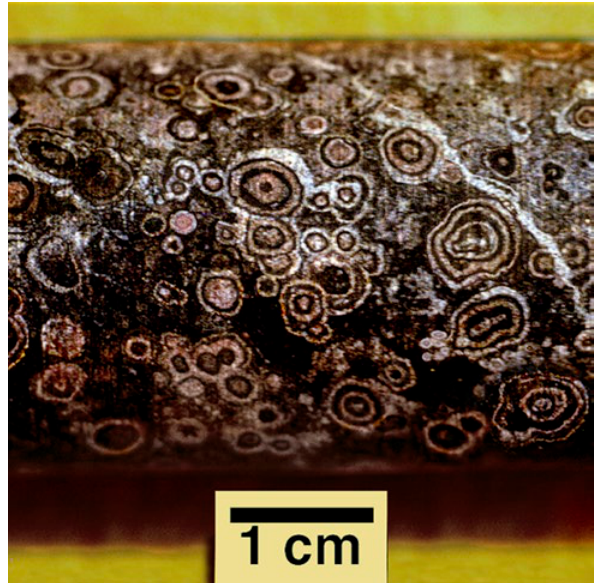
Figure 14. Oolitic hematite oolites in the hematite lode at the Olympic Dam Mine in northern South Australia show that the minerals in this very large lode also crystallised from colloidal fer- ric-hydroxide